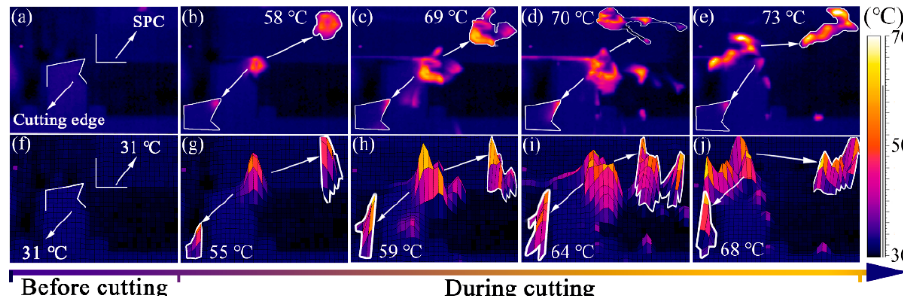
Figure 6. Heat distribution, and the max temperature of chips and cutting edge during SPC machining at cutting depth of 1.1 mm: ( a – e ) Infrared images, ( f – j ) three-dimensional heat maps.